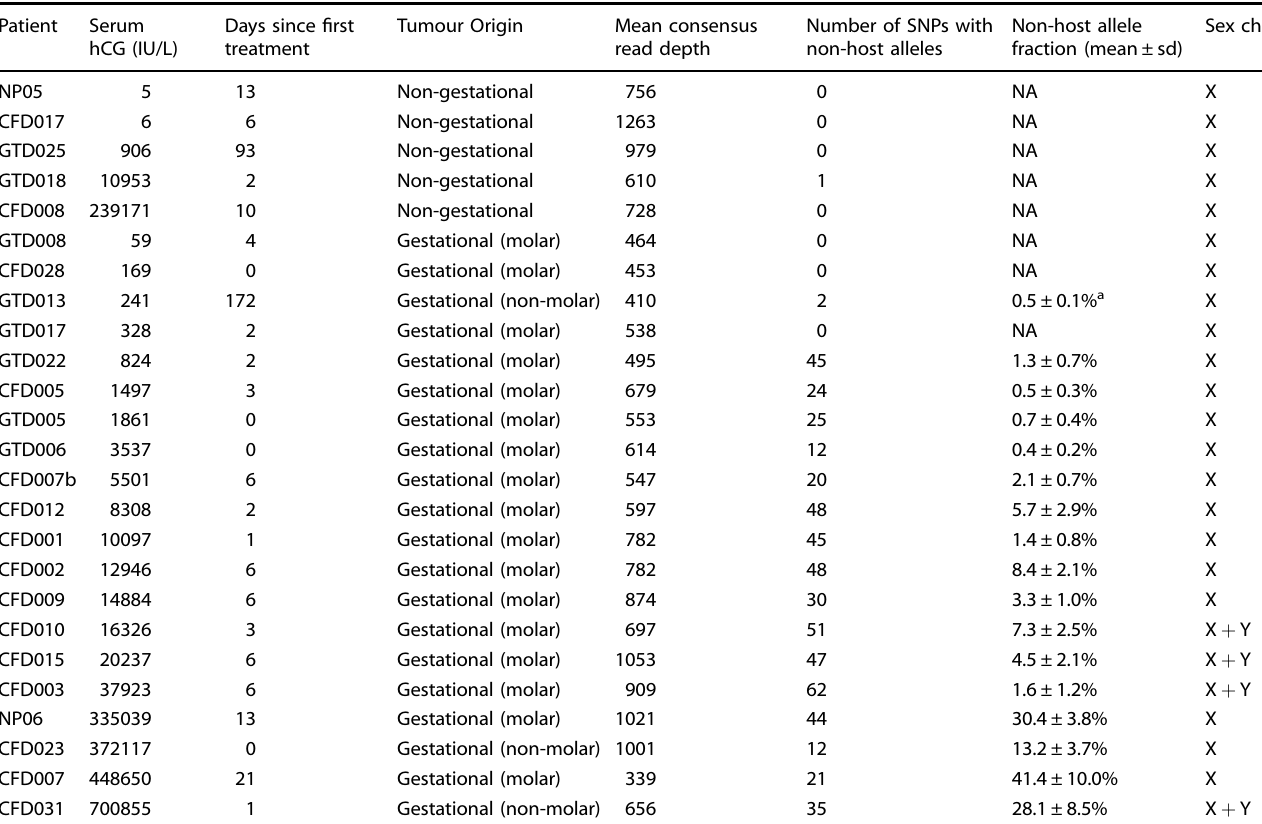
Table 1. Detection of non-host cfDNA in plasma of patients with hCG-secreting tumours of known origin. Patient Serum hCG